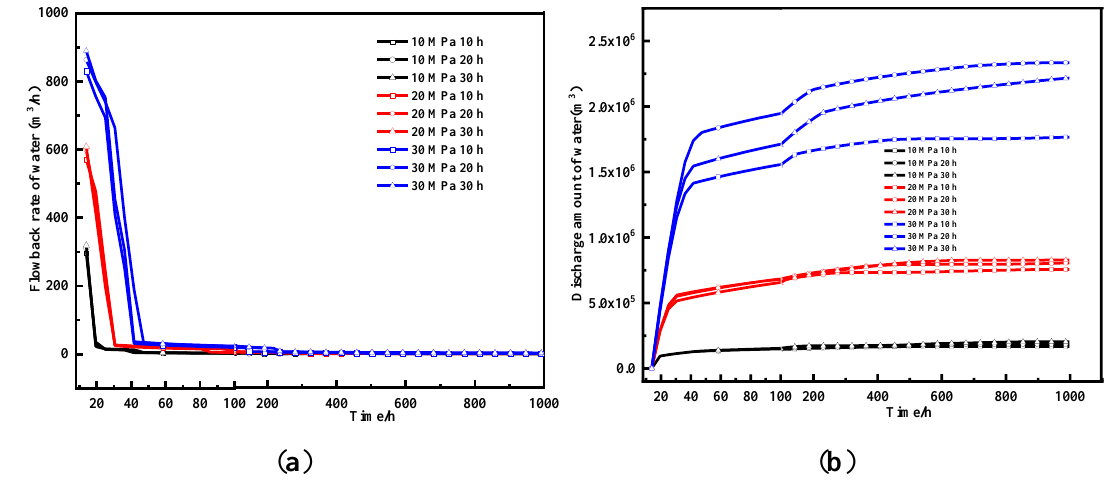
Figure 13. (a) the water flow rate and (b) total water amount versus time.